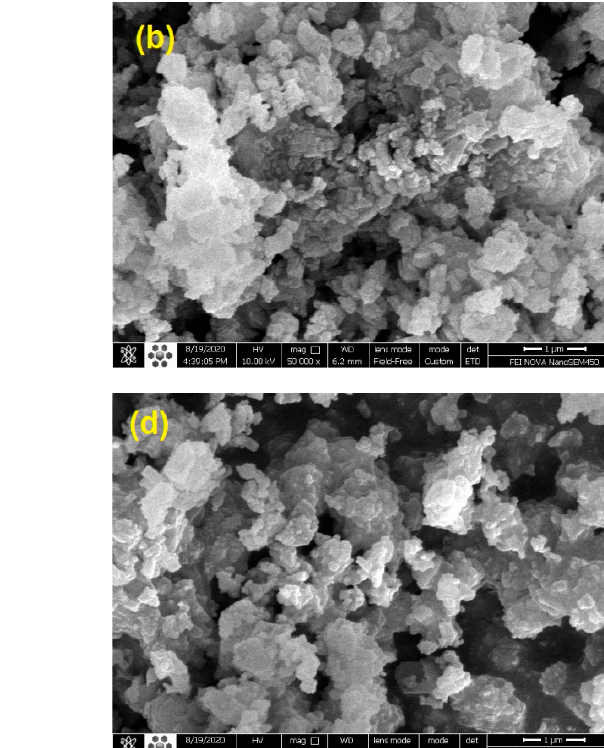
Figure 7. TGA of the fresh parent HZSM-5 and fresh lanthanum-modified HZSM-5 with different loading-weight percentages.